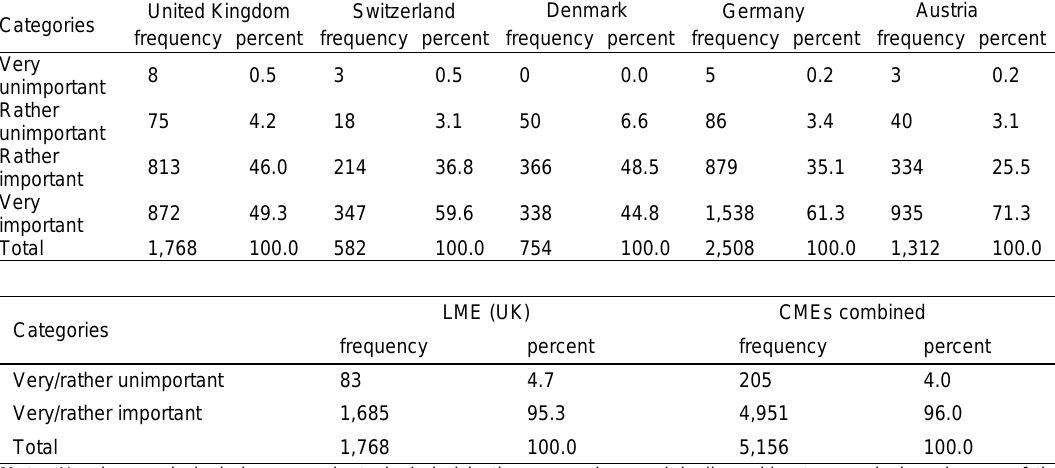
Q13b: What skills and qualities do you think are important to finding a good job in [your country]? – Occupation-specific or job-specific